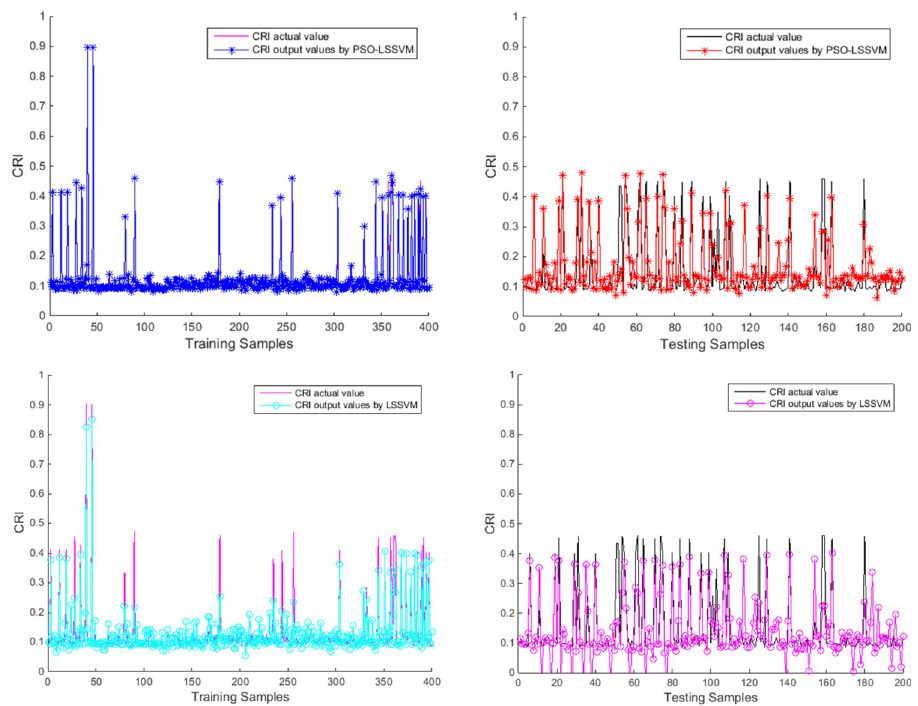
Fig 8. Results of CRI by PSO-LSSVM and comparison of LSSVM results. (a) Training results by PSO-LSSVM (b) Testing results by PSO-LSSVM (c) Training results by LSSVM (d) Testing results by LSSVM.